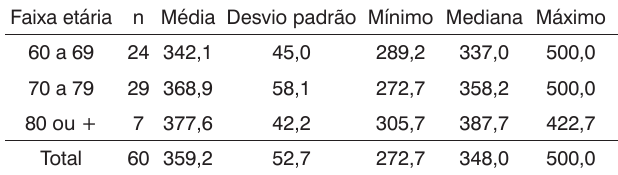
Tabela 3. Estatísticas descritivas para a latência (ms) por faixa etária.